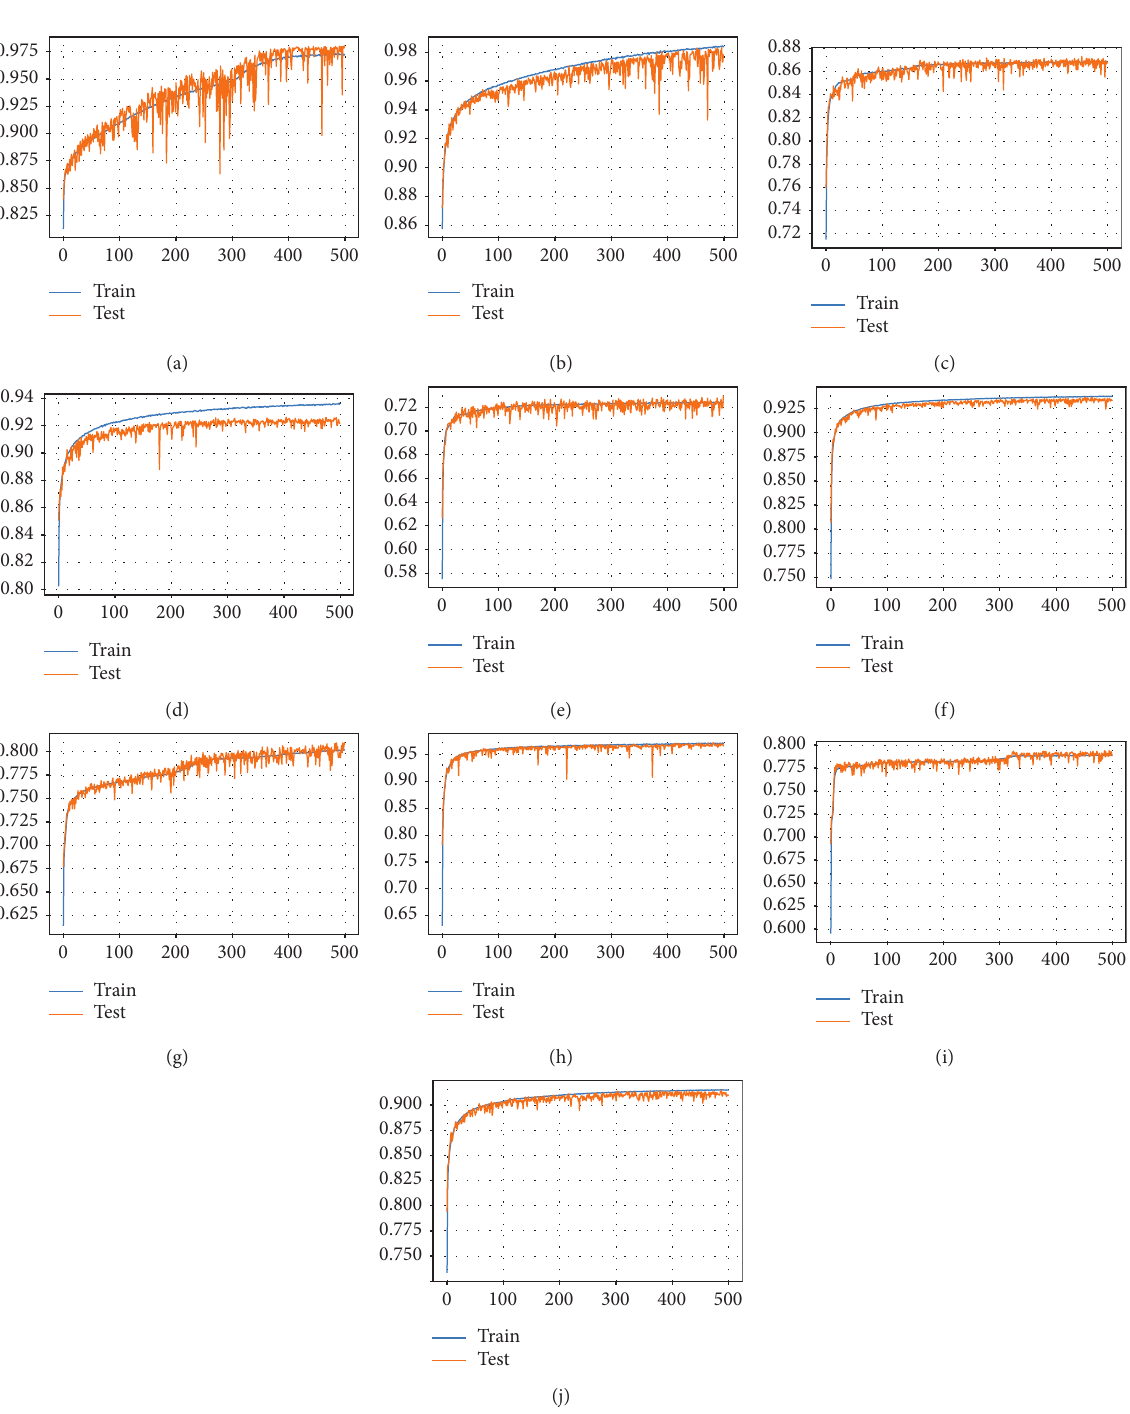
Figure 4: Train and test accuracy in every iteration computed by NN and DNN. (a) Neural network for suicide prediction. (b) Deep neural network for suicide prediction. (c) Neural network for success prediction. (d) Deep neural network for success prediction. (e) Neural network for weapon type prediction. (f) Deep neural network for weapon type prediction. (g) Neural network for region prediction. (h) Deep neural network for region prediction. (i) Neural Network for attack type prediction. (j) Deep neural network for attack type attack type is given in Figure 8. A confusion matrix with size equal to number of classes squared. The confusion large values on the diagonal demonstrate the high accuracy matrix computed by DNN for suicide and success is given in of the model. As shown in these figures, confusion matrix Figure 7. The confusion matrix for weapon type, region, and